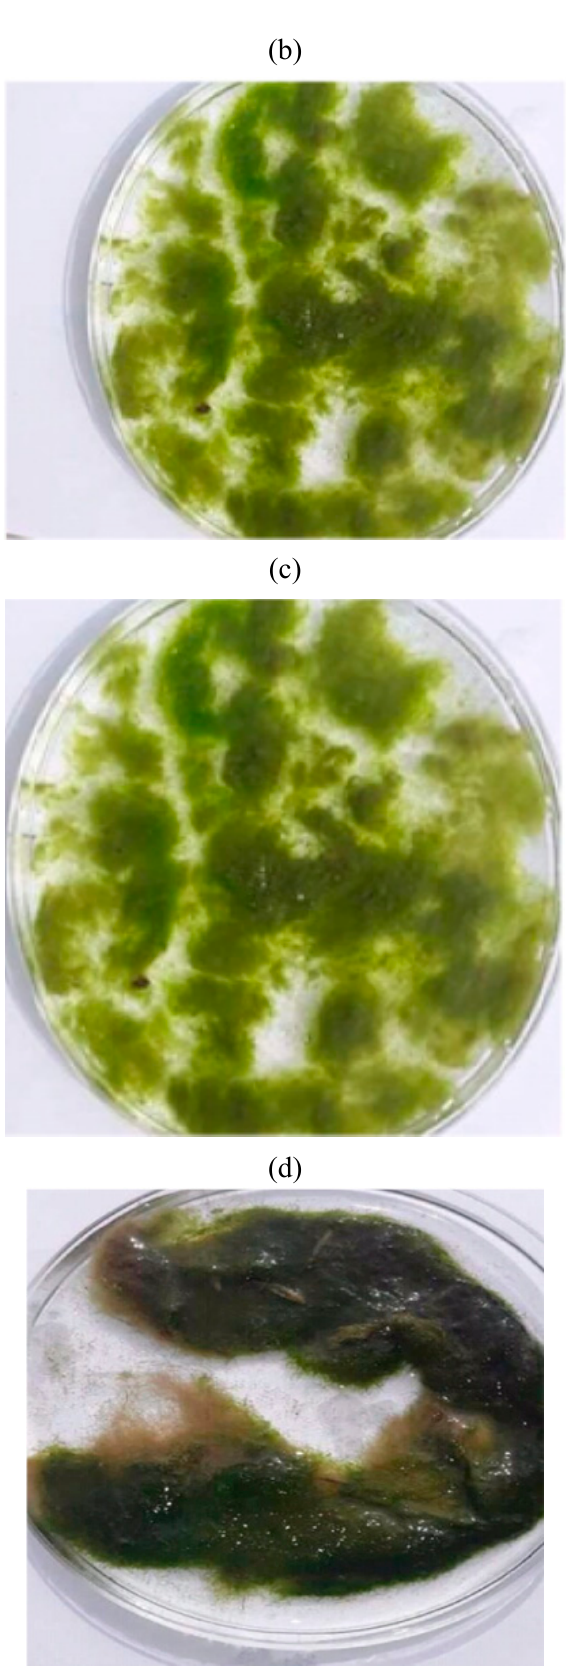
Figure 2. Chlorophyta: ( a ) Chara , ( b ) Zygnema , ( c ) Cladophora , ( d ) Spirogyra